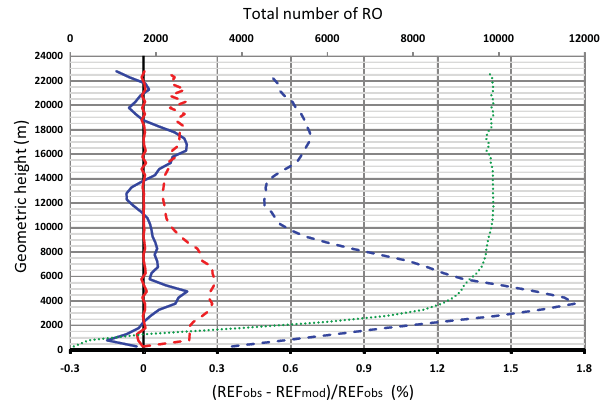
Figure 2. The solid lines are the observation-background (6h fore- cast) deviation (OmB, blue) and observation-analysis deviation (OmA, red) and the dash line are their standard deviation (blue for OmB and red for OmA) averaged over all the cases. The green line represents the total number of assimilated RO soundings. The bot- tom horizontal axis gives the percentage, normalized by observation refractivity, and the top horizontal axis shows the number associated with the green